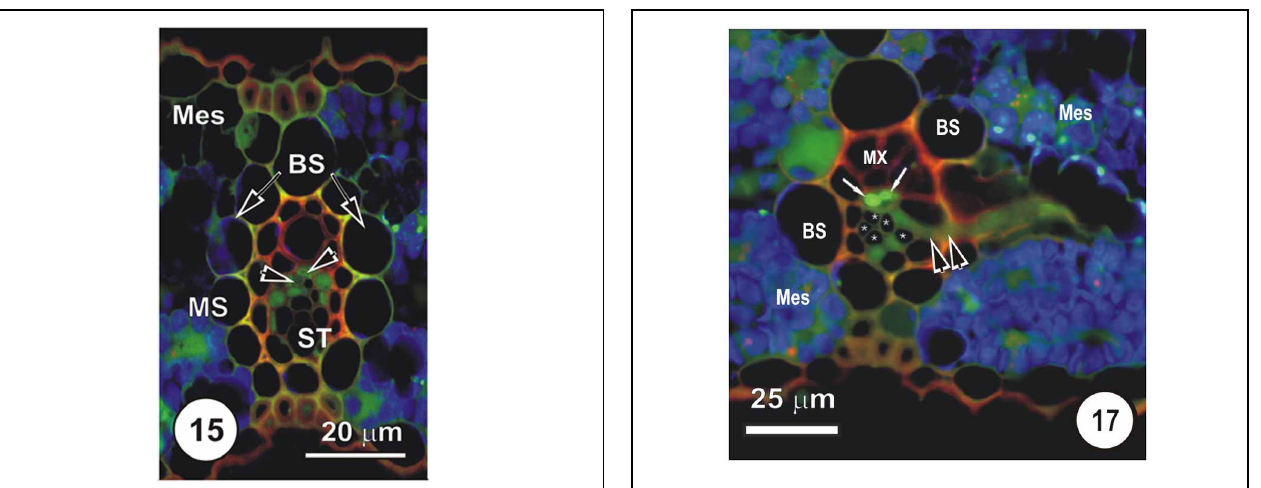
FIGURE 15 | LSCM imaged transections through a small (Figure 14), an intermediate (Figure 15) and a large (Figure 16) longitudinal bundles, showing distribution of 5,6-CF, after uptake of 5,6-CFDA (green fluorescence) co-transported with propidium iodide (red fluorescence; PI stains lignin and cellulosic walls) after 45min uptake and 6cm above the cut end of a rice leaf blade [full methodology in Botha et al. (2008)]. Again, there is no evidence of 5,6-CF in ST, but TST and concomitant VP contain the green fluorescence (arrowheads) 5,6-CF is also present in mesophyll cells (Mes).